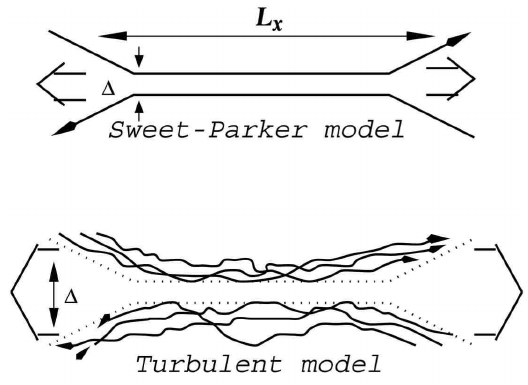
Fig. 1. Upper plot: Sweet-Parker model of reconnection. The out- flow is limited by a thin slot, which is determined by Ohmic dif- fusivity. The other scale is an astrophysical scale L x (cid:29) 1 . Lower plot: Reconnection of weakly stochastic magnetic field according to LV99. The Goldreich-Sridhar (1995) model of MHD turbulence is used to account for the stochasticity of magnetic field lines. The outflow in the LV99 theory is limited by the diffusion of magnetic field lines, which depends on field line stochasticity. From Lazarian et al.